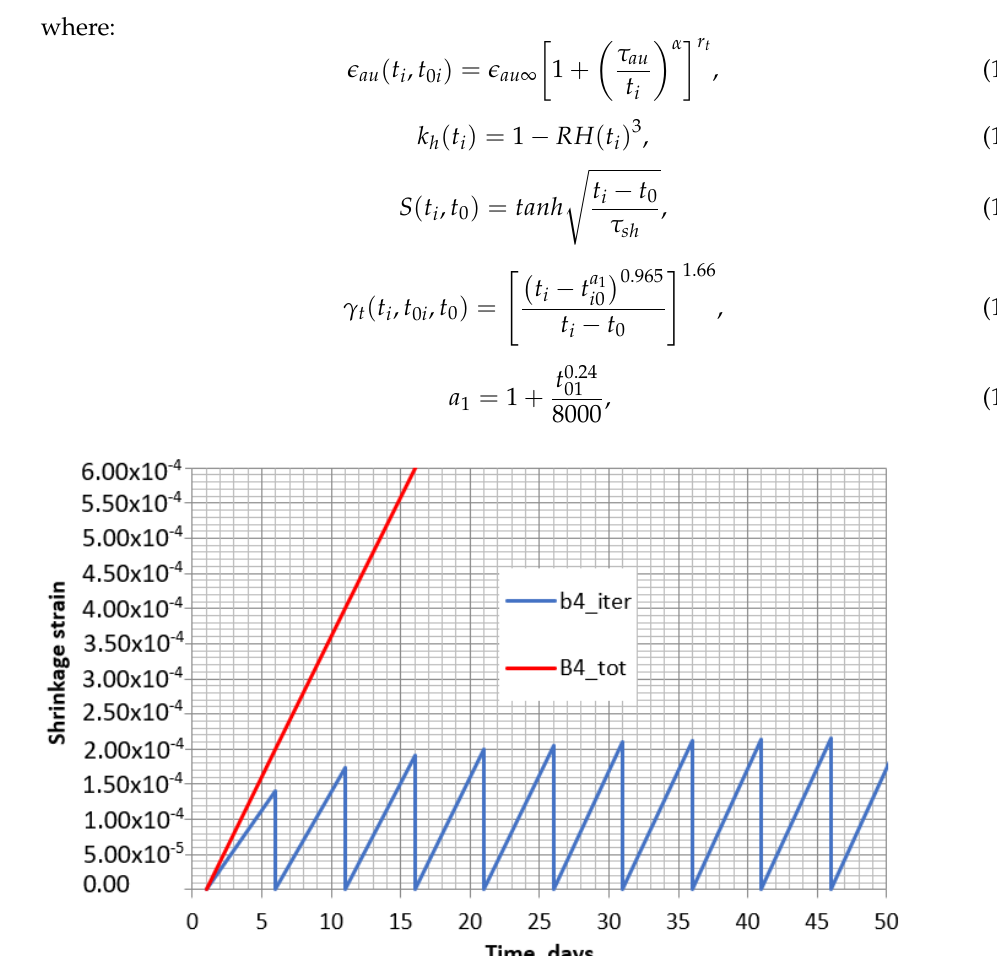
Figure 11. Shrinkage of each separate interval (B4_iter) and their sum (B4_tot) obtained according to model B4 with 70% external humidity.